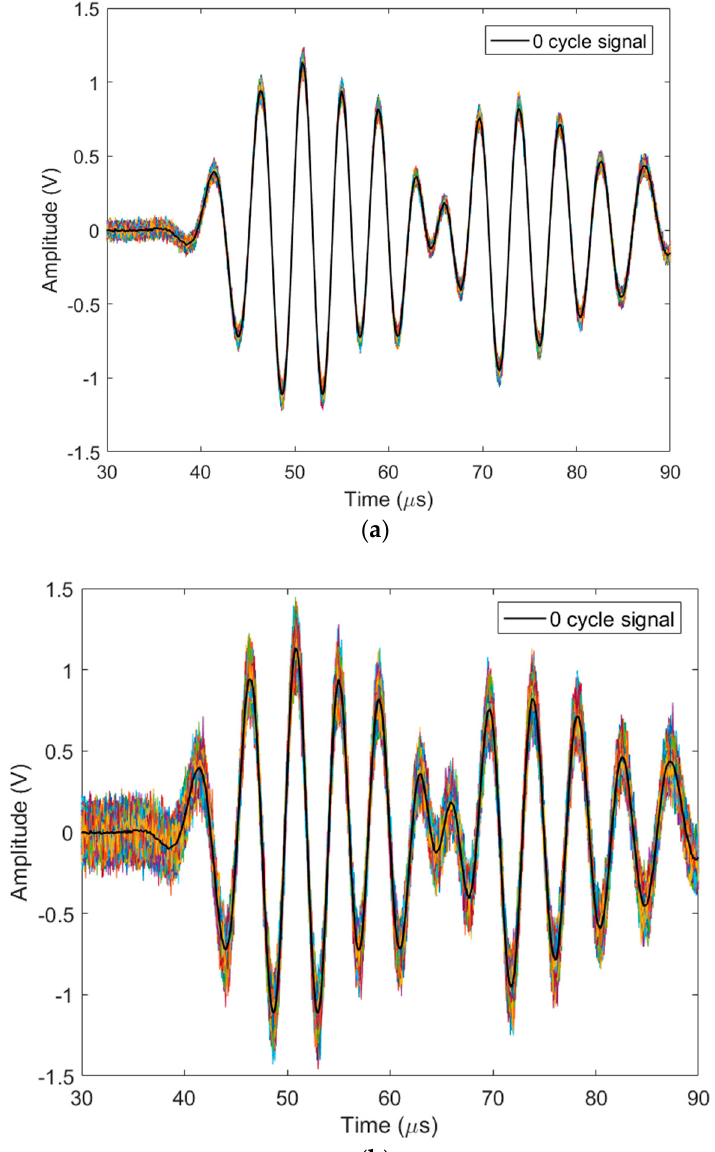
Figure 8. Contaminated baseline signals with different levels for specimen S_A: ( a ) Level 1 contamination and ( b ) Level 2 contamination.